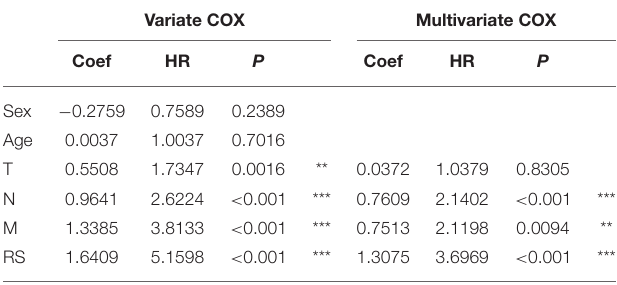
TABLE 2 | The univariate and multivariate Cox regression analysis between RS and other clinical characteristics and OS in diffuse type GC.